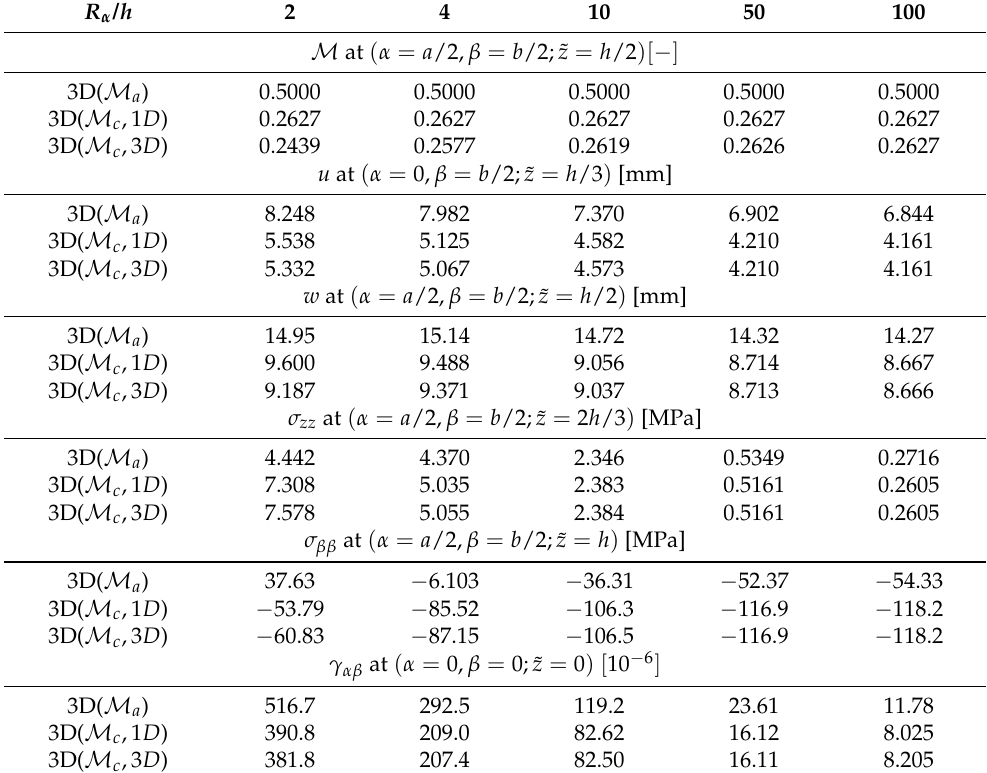
Table 6. Second benchmark: closed cylinder with a single FGM layer subject to an external moisture content applied to the top and bottom surfaces. The results of all the 3D models consider N = 3 and NL =